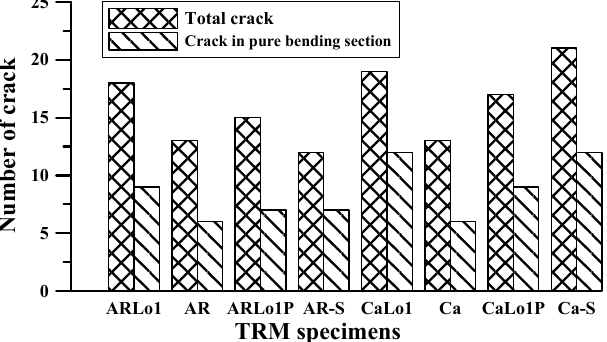
Figure 7. Number of cracks on monotonic and cyclic loading specimens in the RC section.